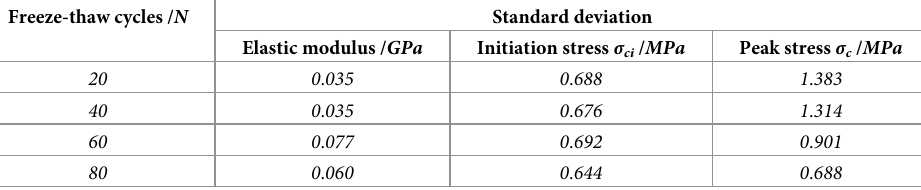
Table 2. The standard deviation of each group of data.